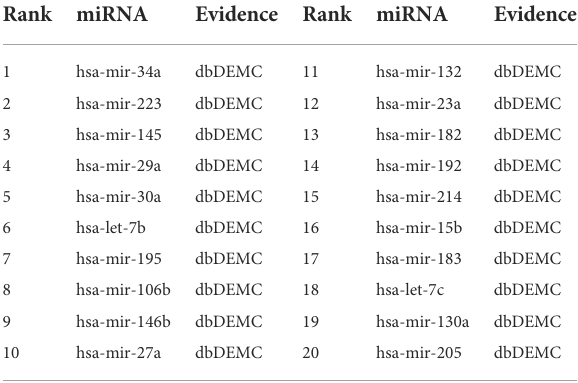
TABLE 7 Top 20 miRNA candidates related to breast neoplasms. The miRNAs associated with breast neoplasms are deleted before training the MVIFMDA